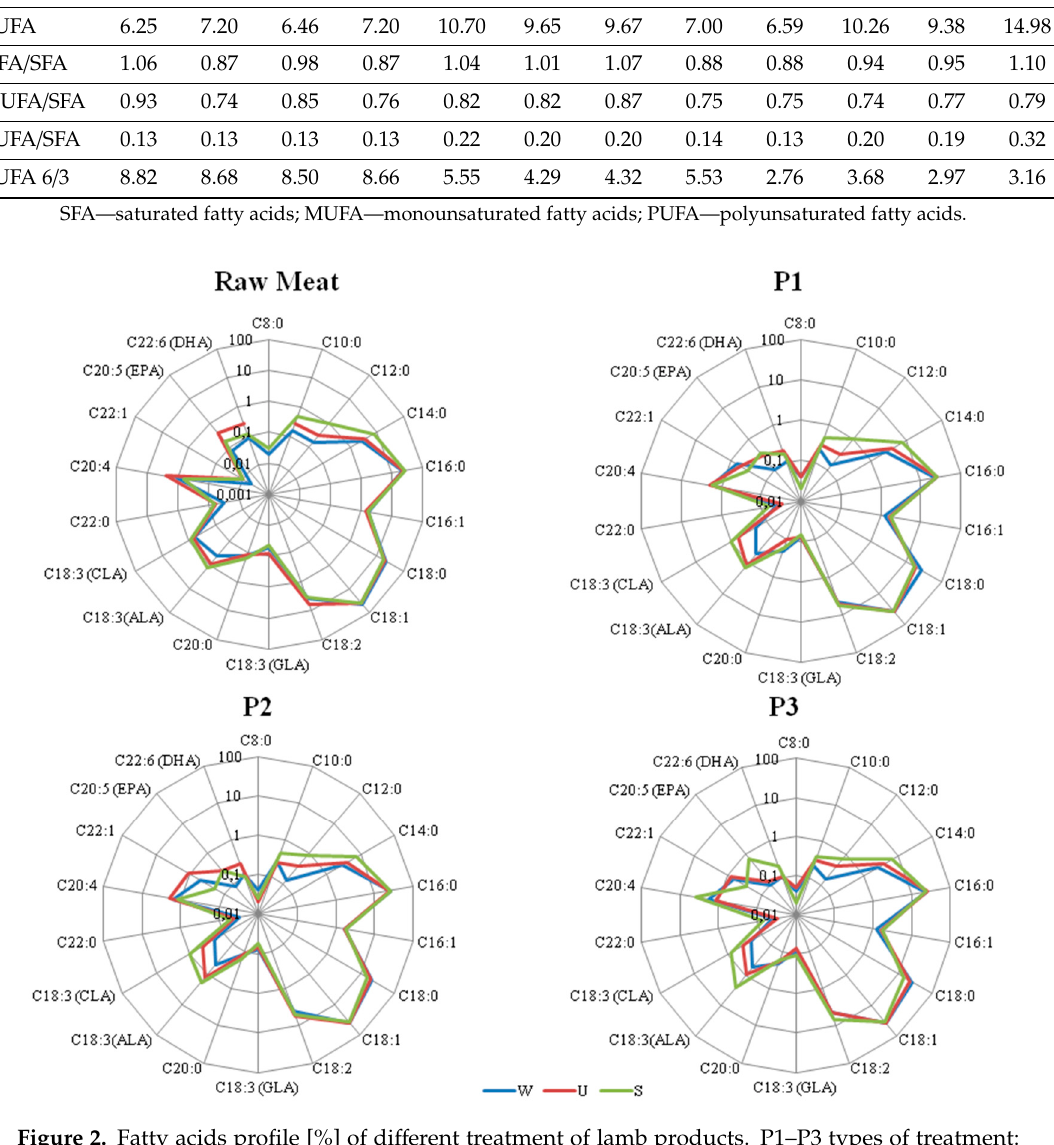
Figure 2. Fatty acids profile [%] of different treatment of lamb products. P1–P3 types of treatment: P1—treatment with sea salt and sodium nitrate, P2—treatment with sea salt, P3—treatment with sea salt and fermented milk. W, U, S — lamb breeds: W — Wrzosówka, U — Uhruska, S —